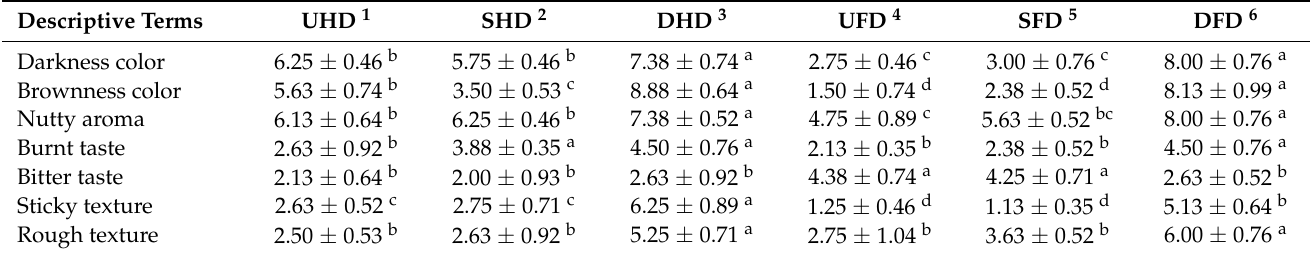
Table 3. Sensory evaluation results by the descriptive test on drone pupae powders processed using different methods.